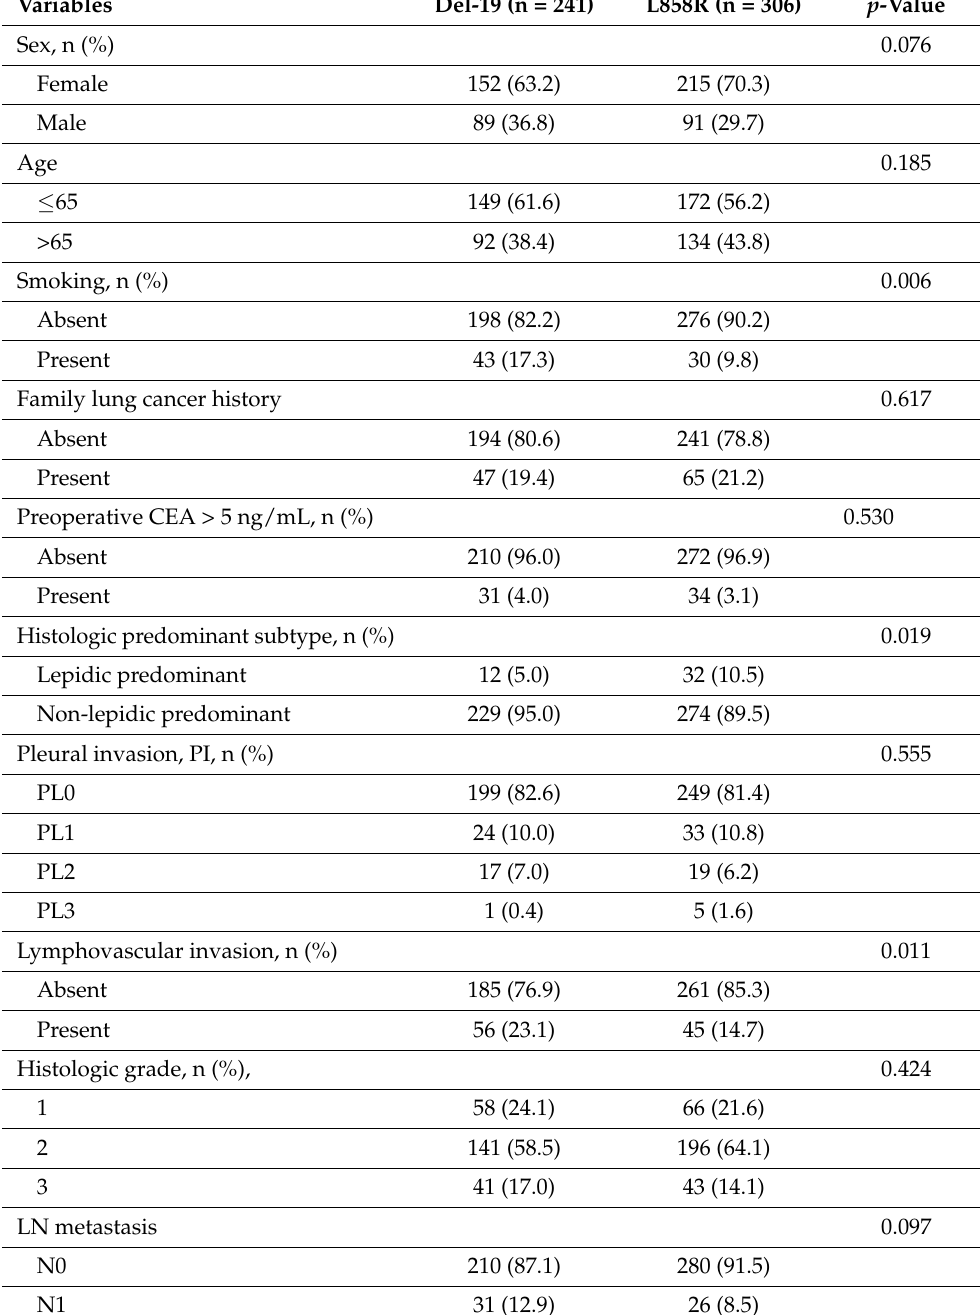
Table 2. Clinicopathological differences between Exon 19 deletion and L858R